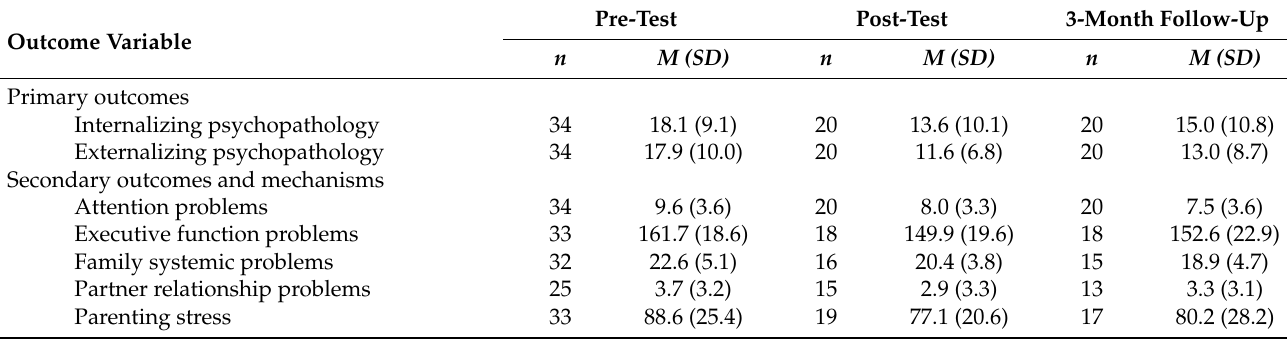
Table 2. Means and standard deviations of sum scores of all outcomes for all measurements; the BOAM diagnostic process and subsequent treatment took place between pre-test and post- test questionnaires.